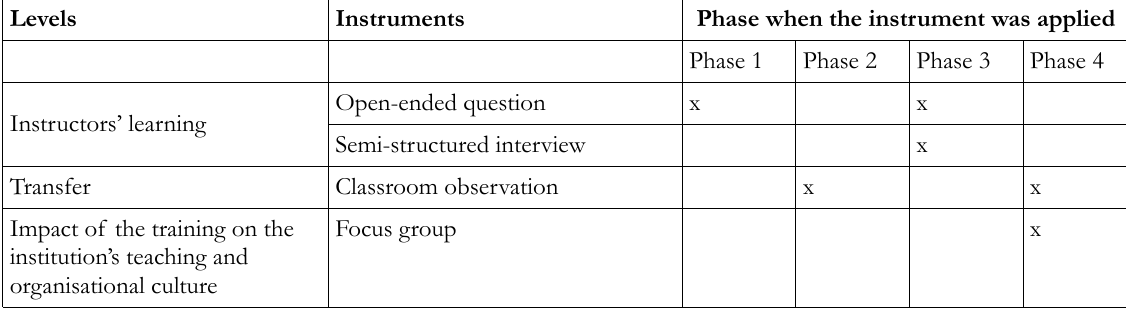
Table 1. Qualitative